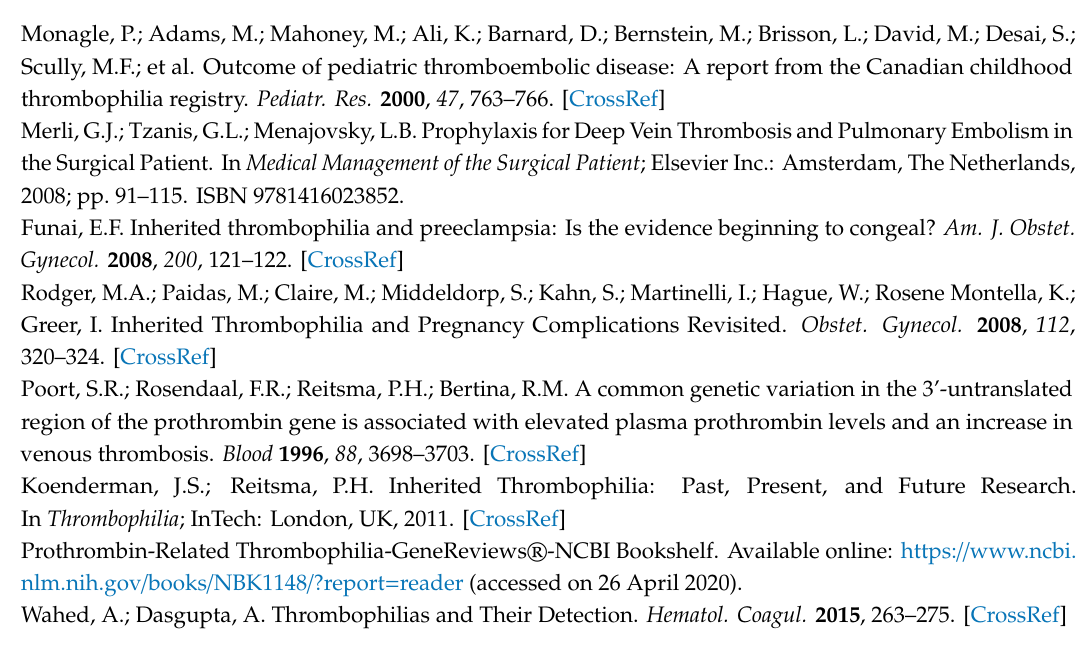
Figure S1: Sensorgram of injections of the MT-C strands (40 nM) into the working channel of the MT biosensor, Figure S2: Sensorgram of injections of the TN-C strands (40 nM) into the working channel of the NT biosensor, Table S1: Responses, surface density and binding sites calculated for the immobilization of MT-A and NT-A on MT and NT biosensors, respectively, Table S2: Responses obtained for the hybridization process between complementary strands at di ff erent concentrations, Table S3: Equations and values of the mathematical adjustments applied in the response versus concentration graph of MT-C injected into the MT biosensor, Table S4: Equations and values of the mathematical adjustments applied in the response versus concentration graph of NT-C injected into the NT biosensor, Table S5: Maximum responses, constants and ligand activity obtained for the MT and NT